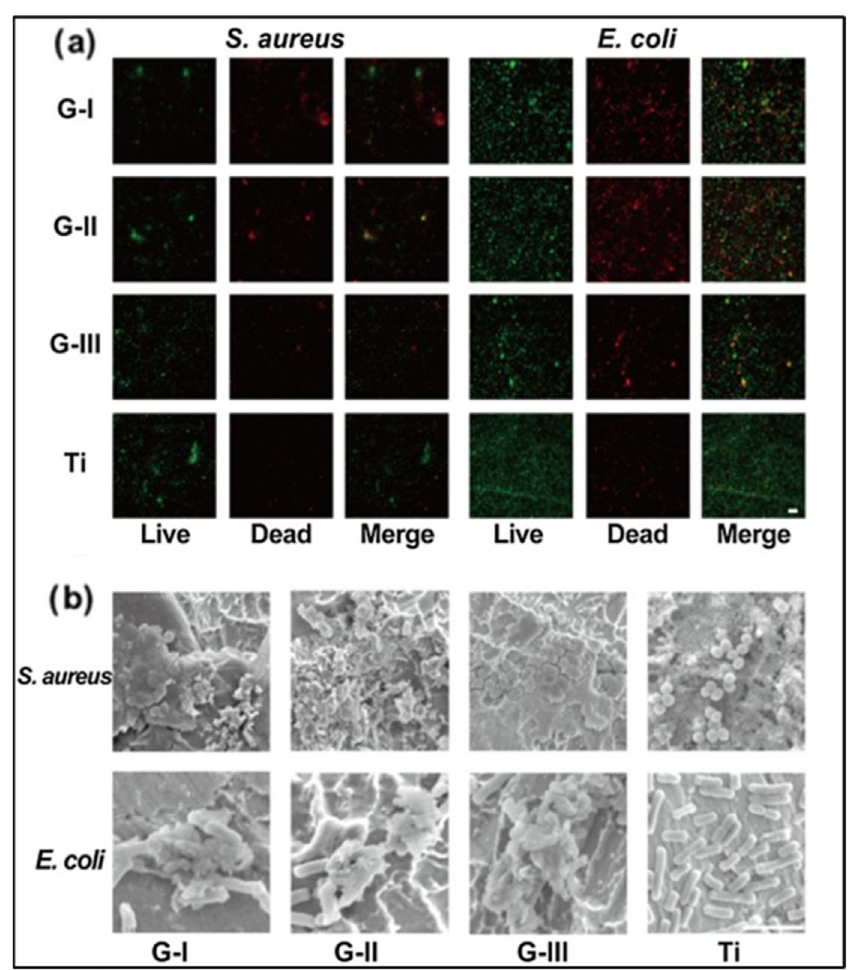
Figure 3. Antibacterial action of graphene ‐ coated Titanium sheets. ( a ) Live/dead fluorescent staining images of bacteria adhered to the graphene ‐ coated Titanium sheets and Titanium sheet. (Live bacteria were stained fluorescent green, and deadly bacteria were stained red.) (Scale bar: 10 μ m). ( b ) SEM images showing the bacteria morphology adhered to the surface of the Titanium and graphene-coated sheets. (Scale bar: 10 μ m). (Reprinted with permission from [99] Copyright 2021, Elsevier).